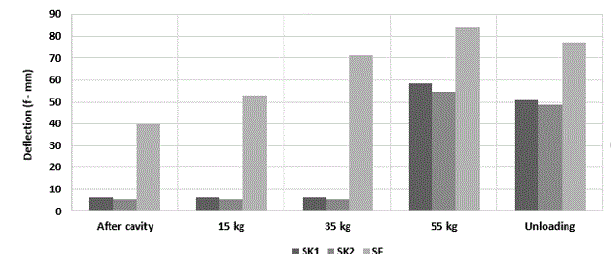
Figure 15. Comparison of the maximum deflection of the geosyn- thetic during the different phases of the loading